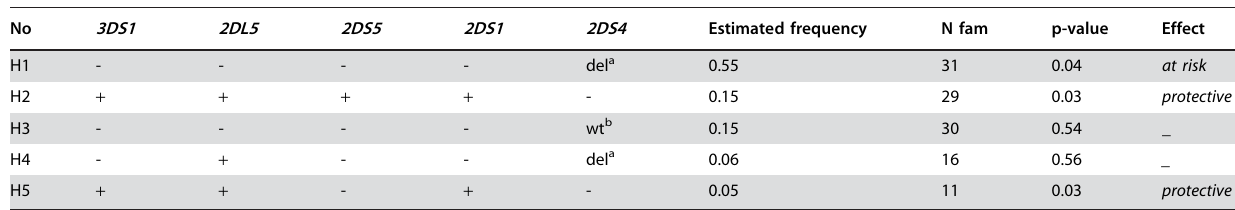
Table 3. Association study based on haplotypes constructed from five KIR genes .. ... .... ... ... .... ... ... .... ... ... .... ... ... .... ... ... .... ... ... .... ... ... .... ... ... .... ... ... .... ... ... .... ... ... .... ... ... .... ... ... .... ... ...